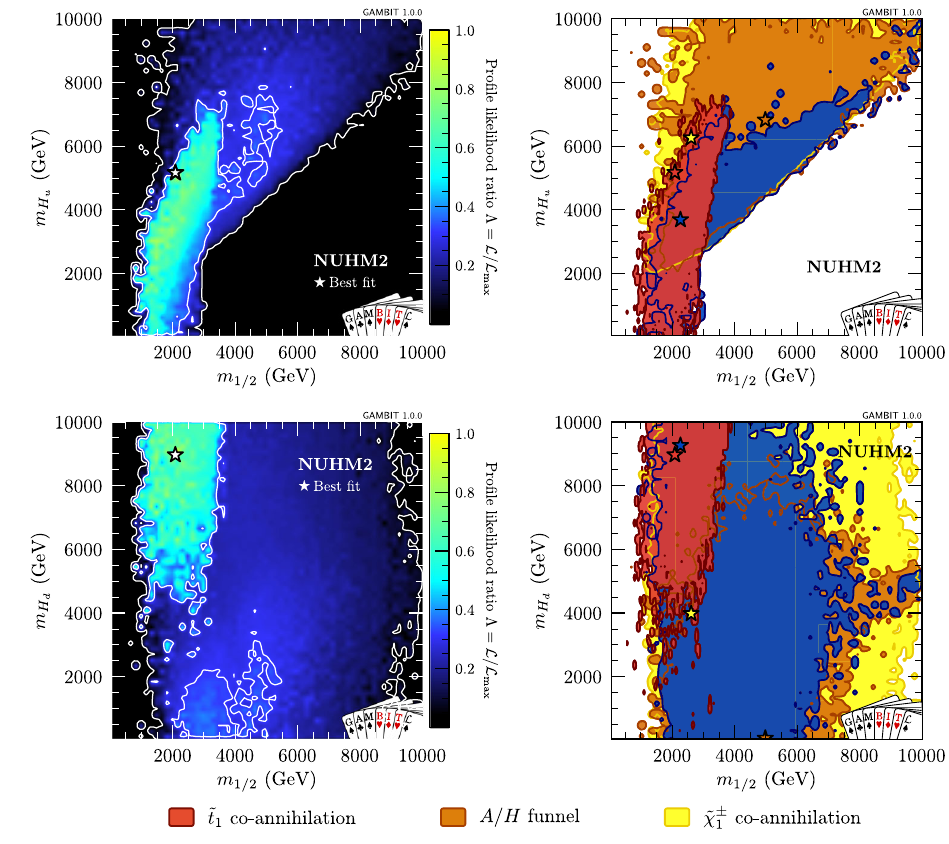
Fig. 9 As per Fig. 8, but for the m H